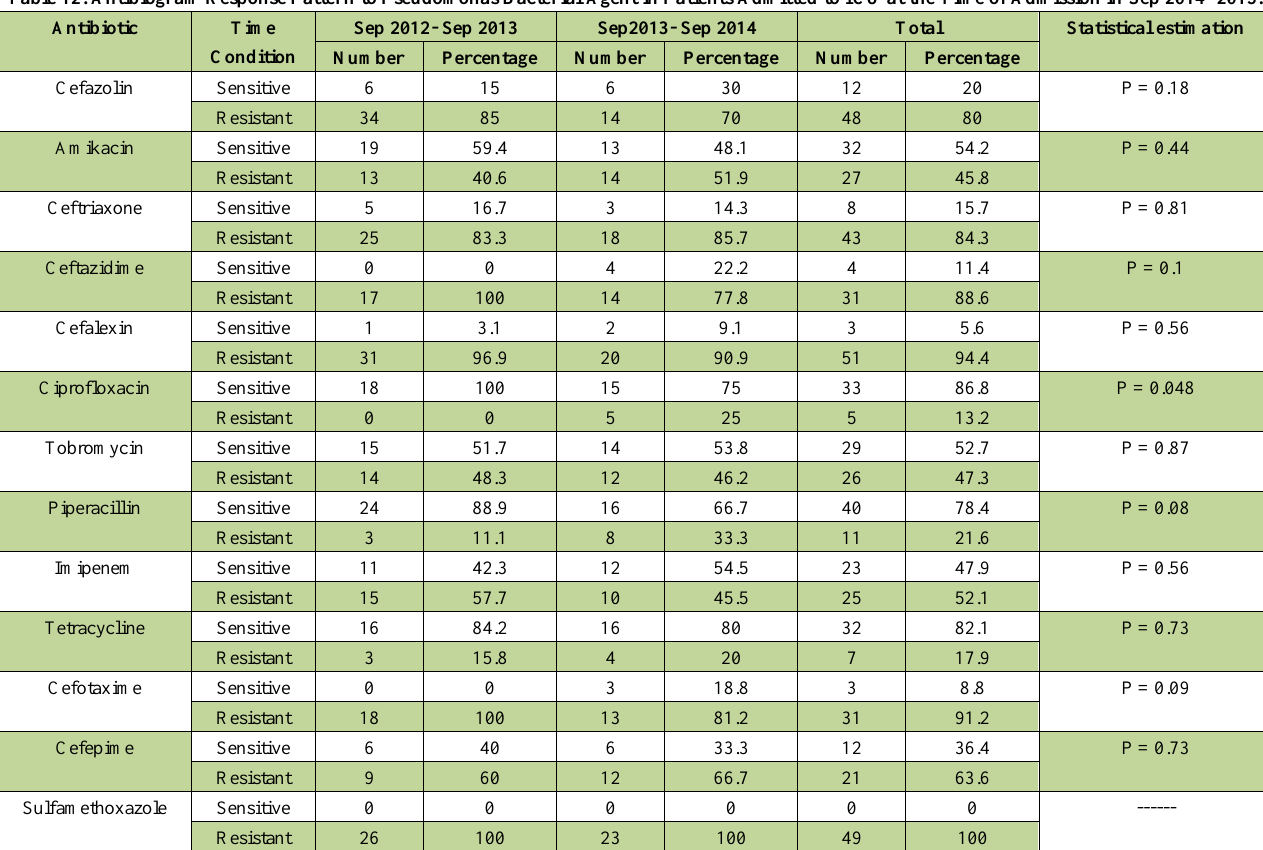
Table 12. Antibiogram Response Pattern to Pseudomonas Bacterial Agent in Patients Admitted to ICU at the Time of Admission in Sep 2014- 2015. Antibiotic